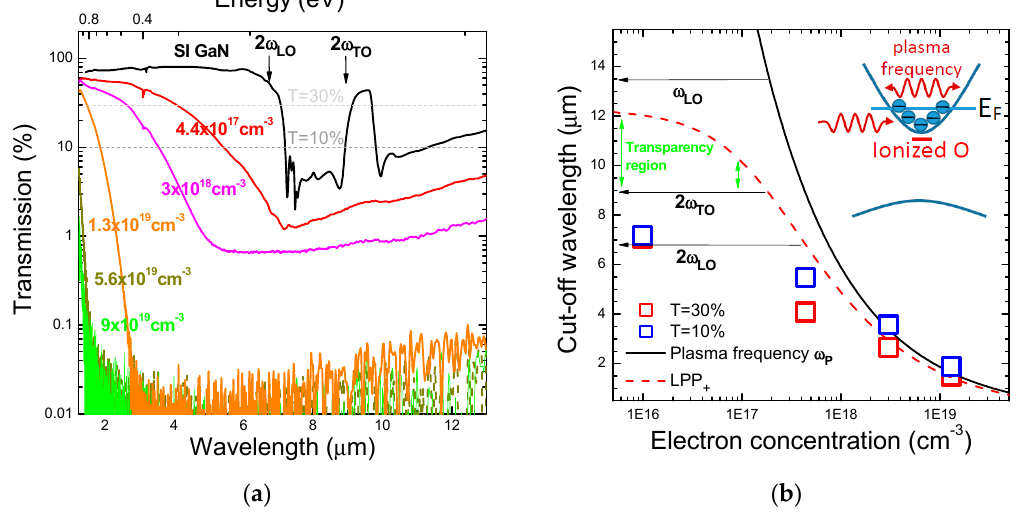
Figure 3. ( a ) Transmission spectra of n-type GaN of various electron concentrations (color lines) together with a transmission spectrum of SI GaN measured at room temperature in the near- and mid-infrared spectral region. ( b ) The transparency cut-off wavelength (open squares) for n-type GaN of various electron concentrations taken at the transparency of 10% (blue points) and 30% (red points) together with curves representing plasma frequency and high energy branch of longitudinal phonon-plasmon (LPP + ). In the sketch E F means the Fermi level.